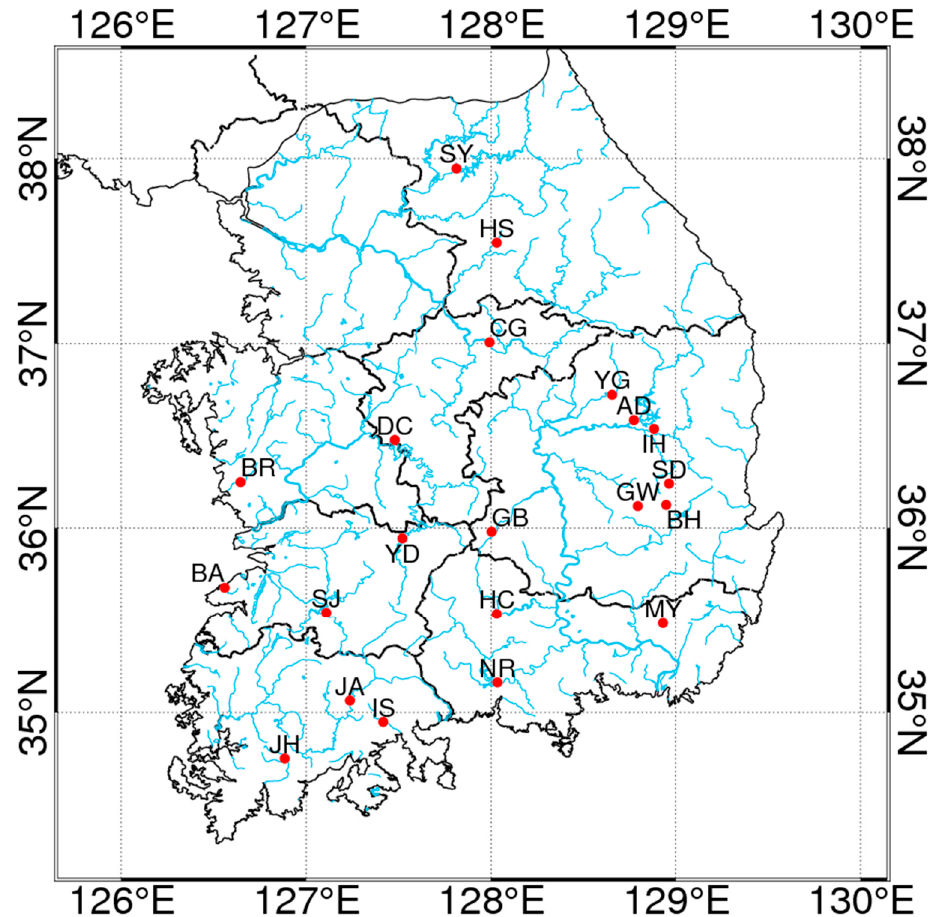
Figure 1. Locations of rivers and 21 multipurpose dams in the Korean Peninsula. Table 1. Characteristics of 21 multipurpose dams.